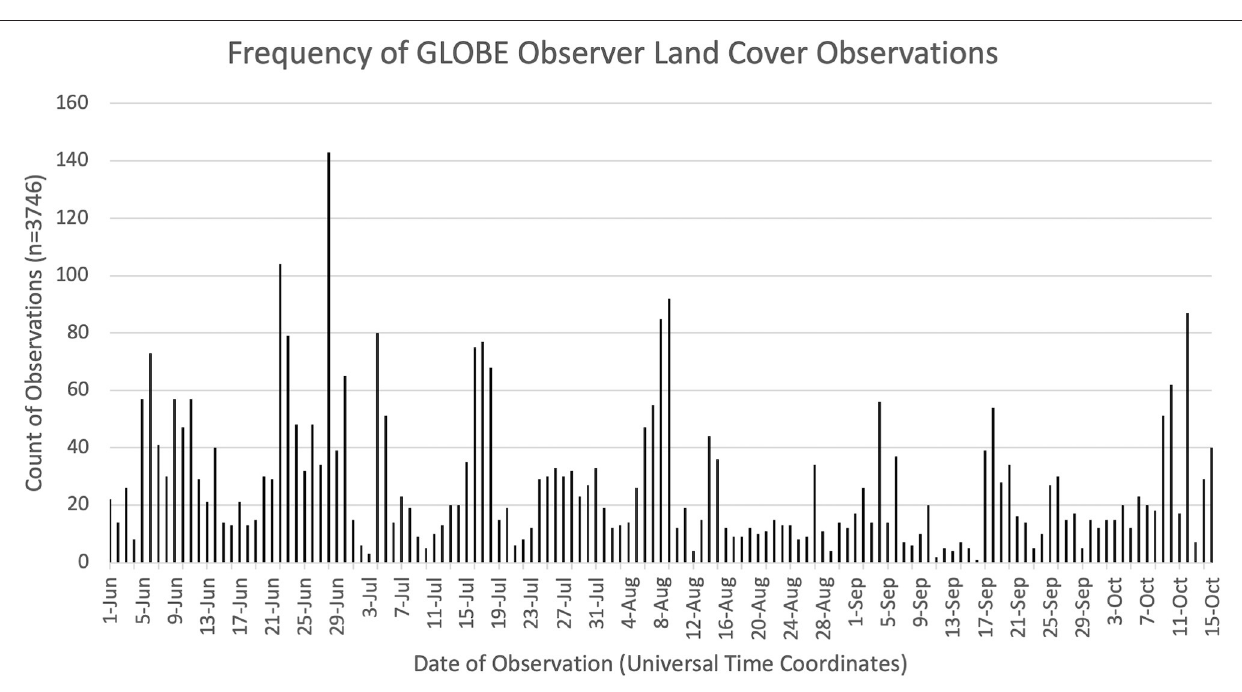
Most observations were collected in dry conditions when leaves were on the trees, Table 1 . Twenty-five percent of the observations include optional classification data, Table 2 . For